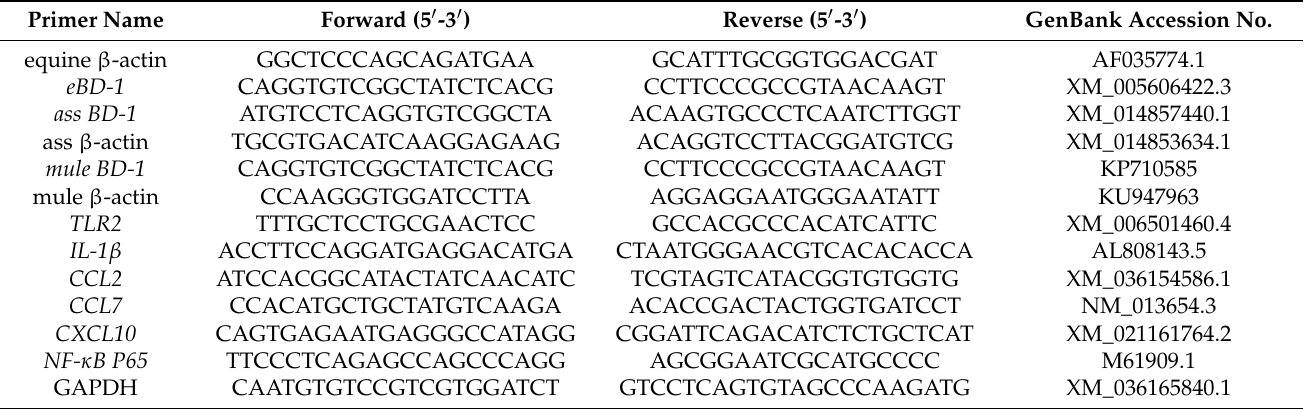
Table 1. The primer messages of PCR and qPCR.